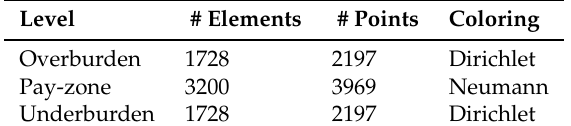
Table 1. Grids for Example 1 in Section 5.1.